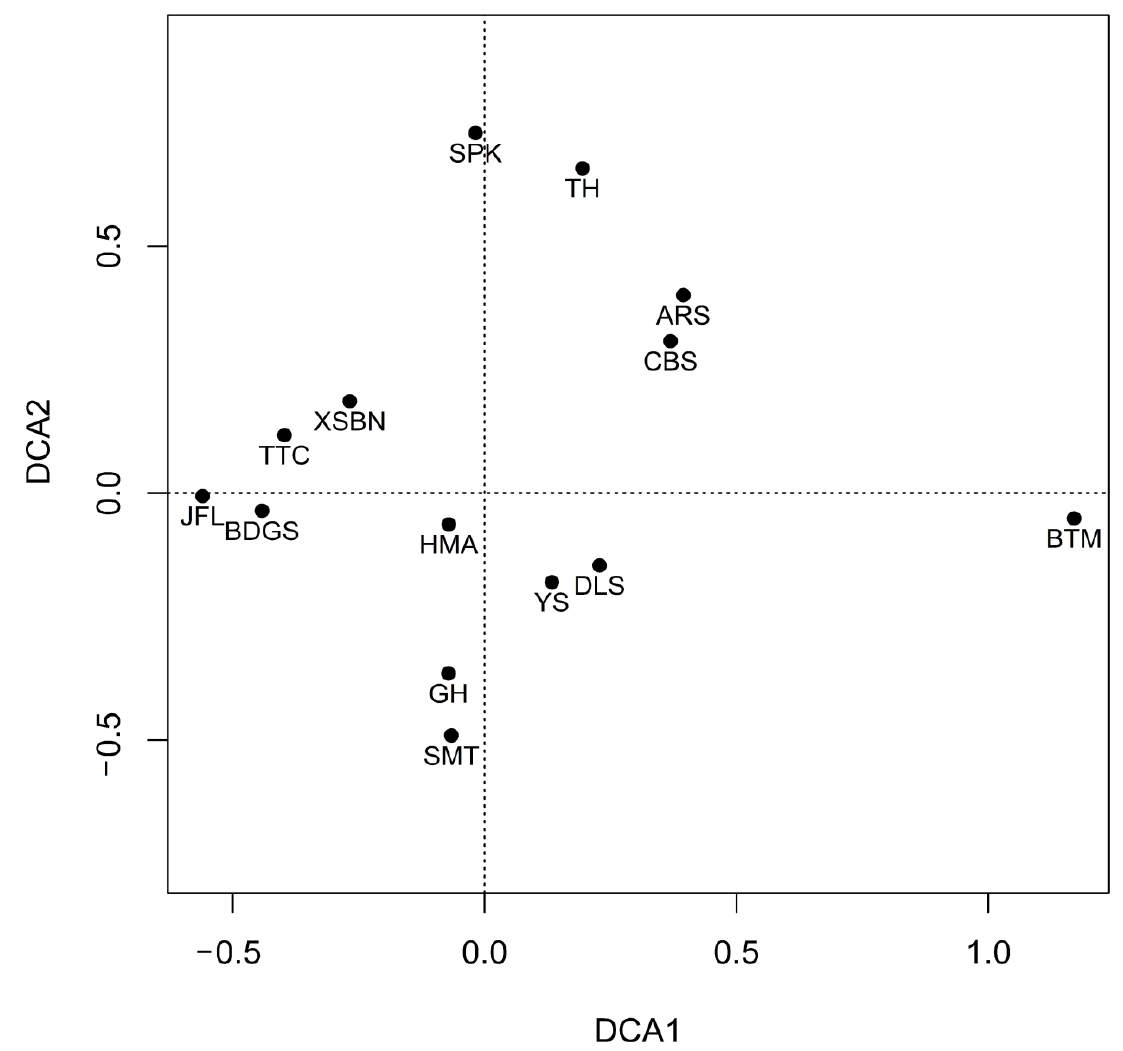
Figure 3. DCA analysis of soil fauna order compositions among the 14 sampling sites in East Asia, with TH = Tahe, ARS = Aershan, CBS = Changbaishan, DLS = Donglingshan, BTM = Baotianman, BDGS = Badagongshan, TTS = Tiantongshan, SMT = Shimentai, JFL = Jianfengling, XSBN = Xishuangbanna, GH = Guanghua, SPK = Sapporo, HMA = Hiroshima and YS = Yushan.